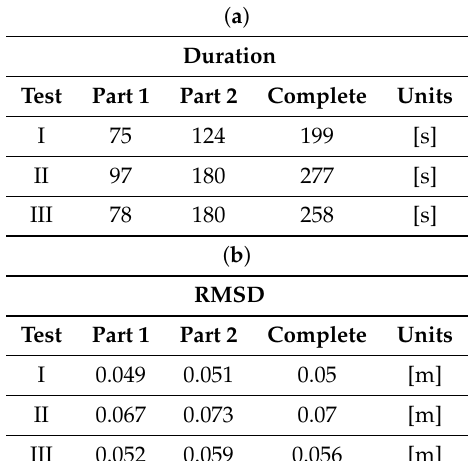
Table 6. The duration of each test per different parts and the RMSD of the vehicle position with respect to the reference